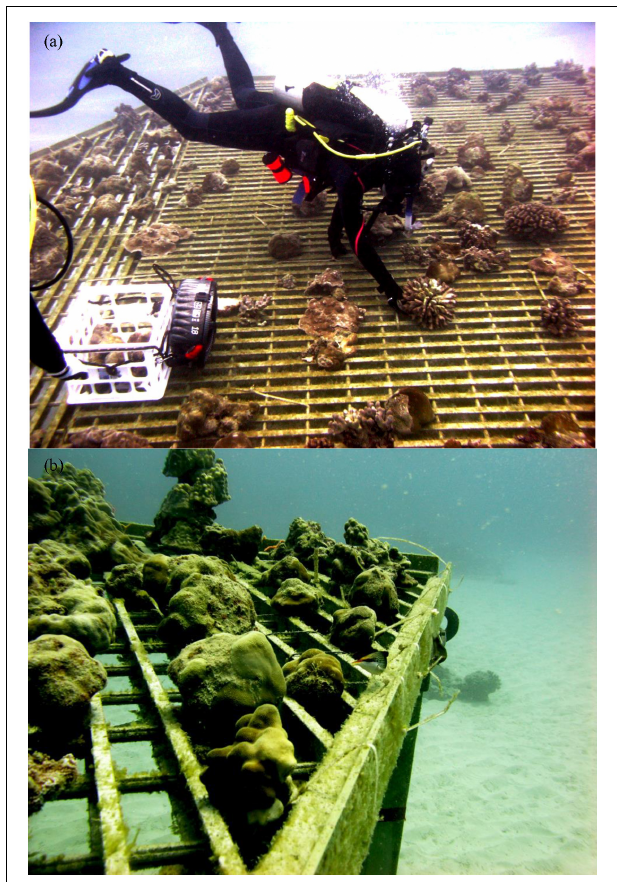
FIGURE 6 | (a) Diver unloading corals onto coral structure. The transport basket and harnessed underwater scooter can be seen in the bottom left of the photo, and (b) corals slotted into the spaces between the grating without the need for extra supports.